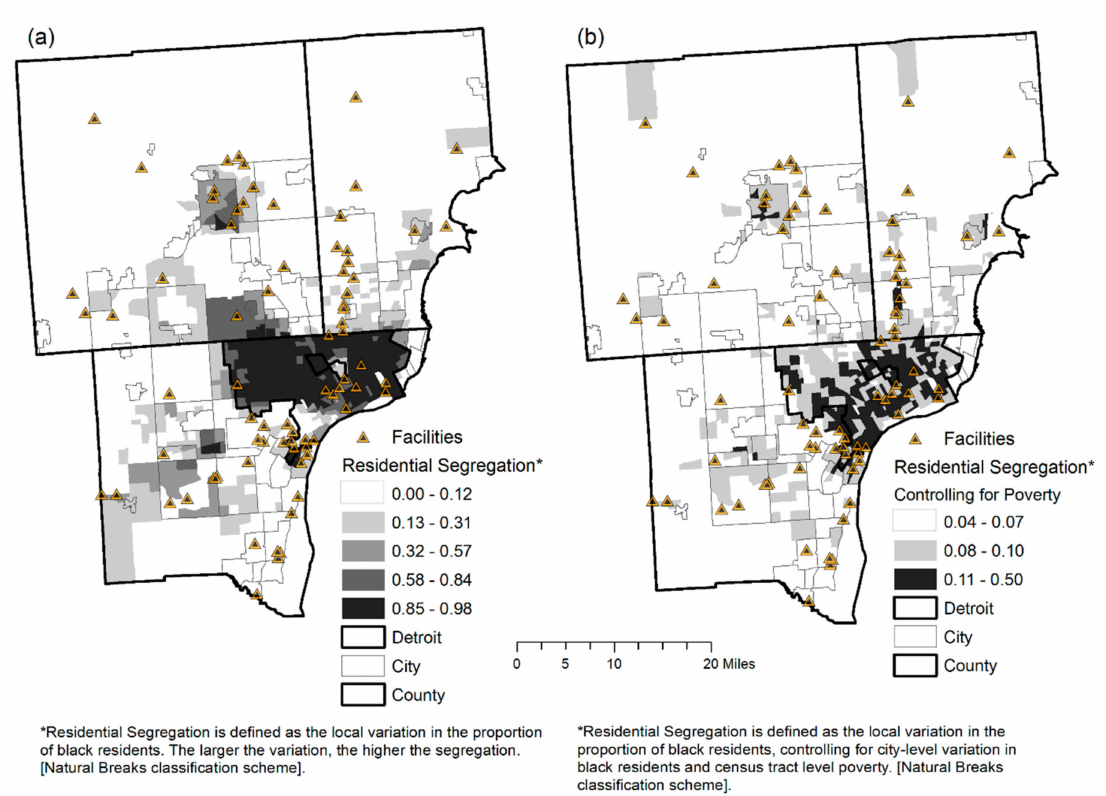
Figure 2. Reference maps—racial residential segregation across census tracts in the Detroit Metropolitan Area, 2010. ( a ) residential segregation is defined as the local variation in the proportion of black residents. The larger the variation, the higher the segregation. ( b ) residential segregation is defined as the local variation in the proportion of black residents, controlling for city-level variation in black residents and census tract level